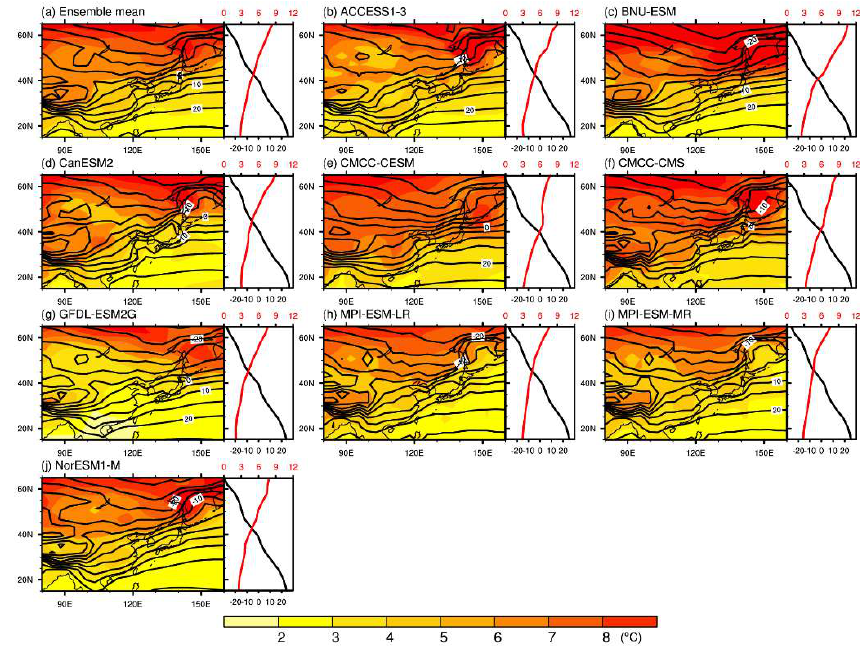
Figure 9. The SAT climatology for the historical run (1975–2005; shown as a contour with intervals of 5 °C). Changes in SAT between 2065–2095 and 1975–2005 (shading; left) from nine CGCMs and their ensemble mean. The climatology of zonal mean SAT along 80° E to 160° E (black lines) and its change (red lines) in winter from nine CGCMs and their ensemble mean.